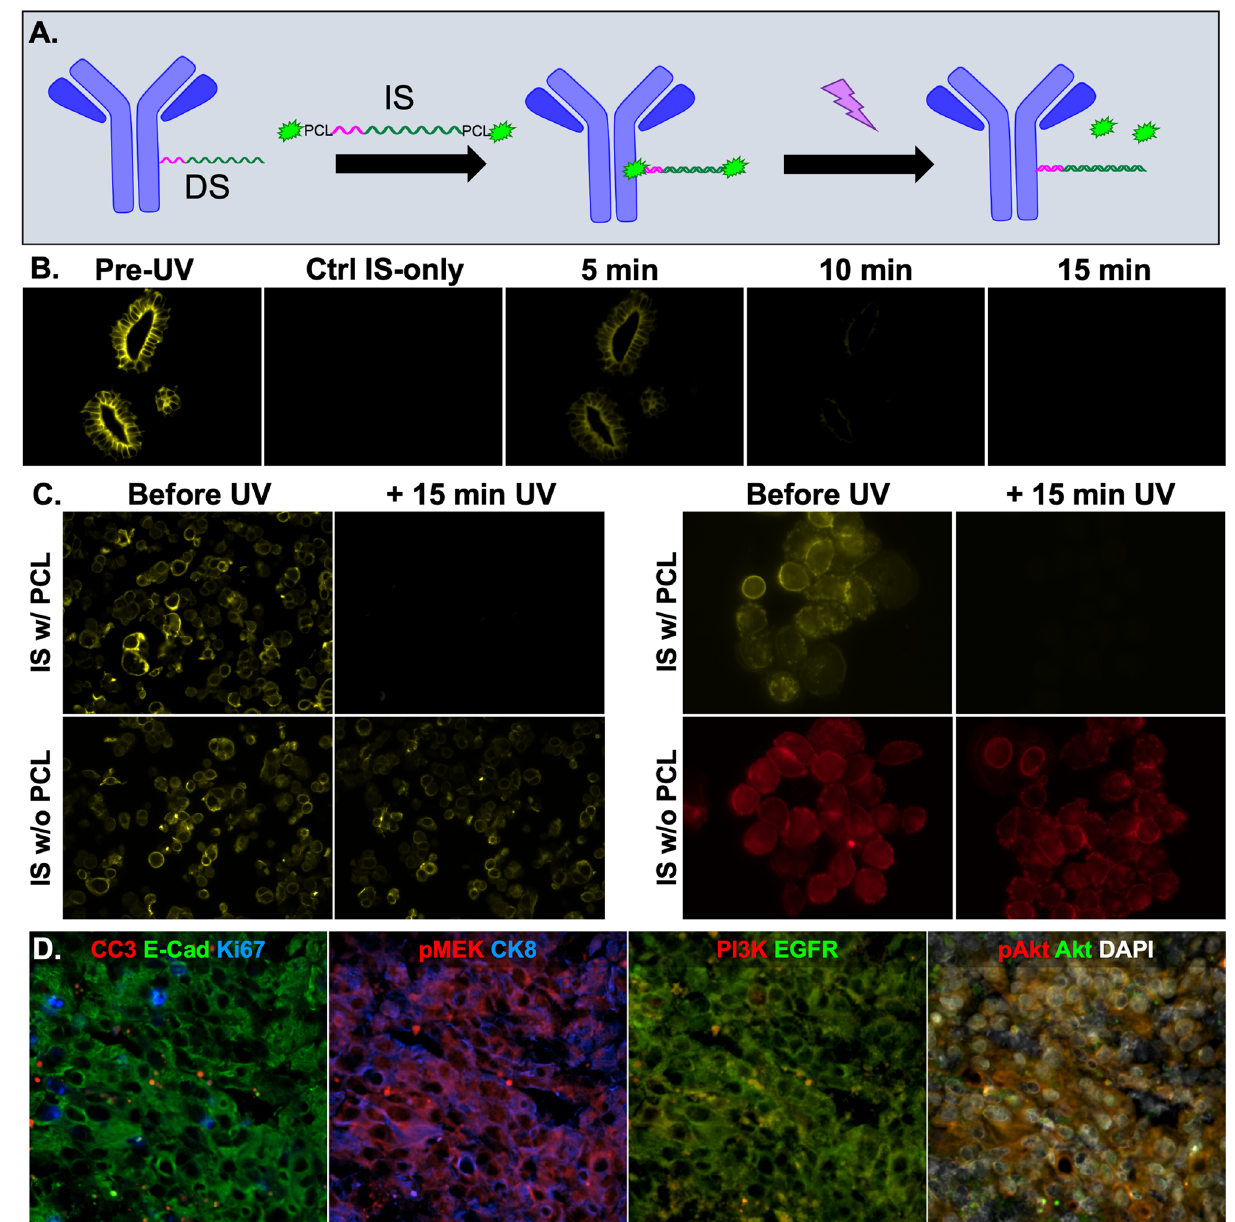
cleaved the fluorophore at the PCL so that it could be readily washed from the sample removing fluorescence signal. ( B ) Tissues stained with CK19 Ab-oligo conjugate and PCL-containing IS were imaged and then treated with UV-light for 15 min with imaging performed of the same FOV every 5 min. ( C ) CK19 (left) and HER2 (right) Ab-oligo conjugates were stained with IS either with or without a PCL, imaged, treated with UV light and re-imaged. ( D ) A nine-color image was generated of a HCC827 xenograft using Ab-oligo conjugates for E-cadherin (E-Cad), Ki-67, CK8, EGFR, PI3K, pAKT, Cleaved Caspase 3 (CC3), pMEK and AKT imaged with the optimized Ab-oligo cyCIF